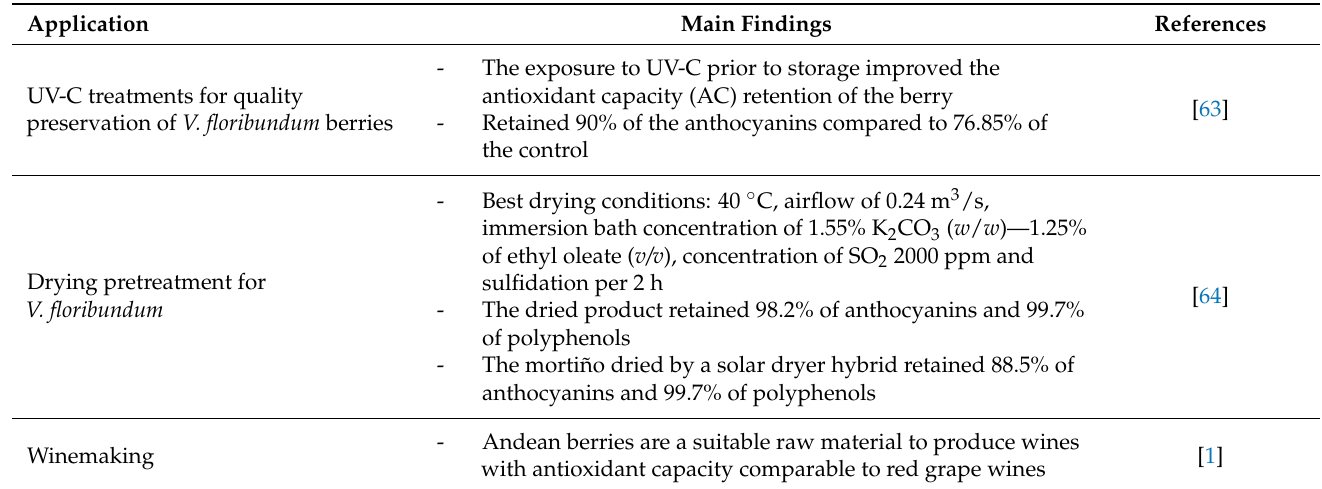
Table 5. Berry quality preservation